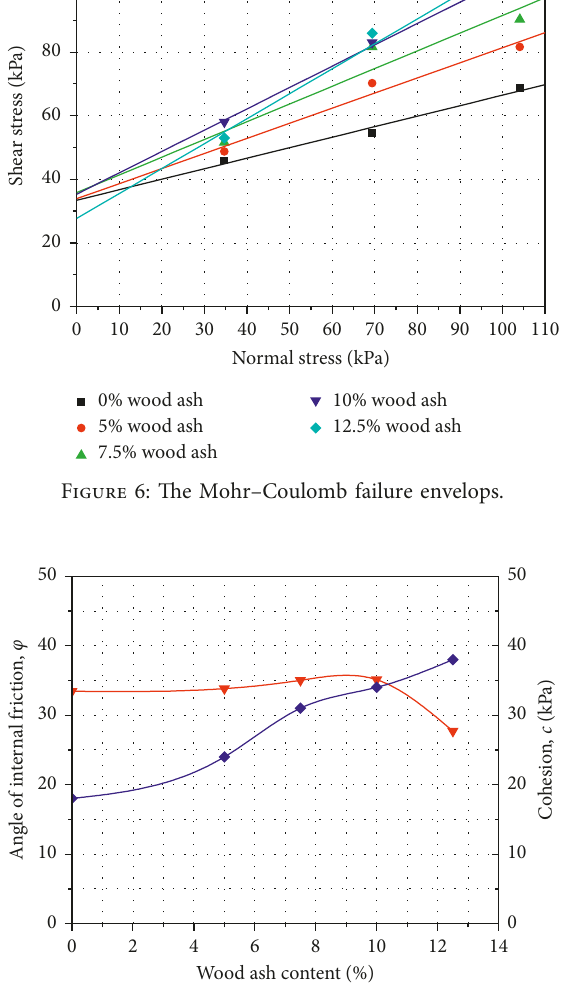
0 ) and compression